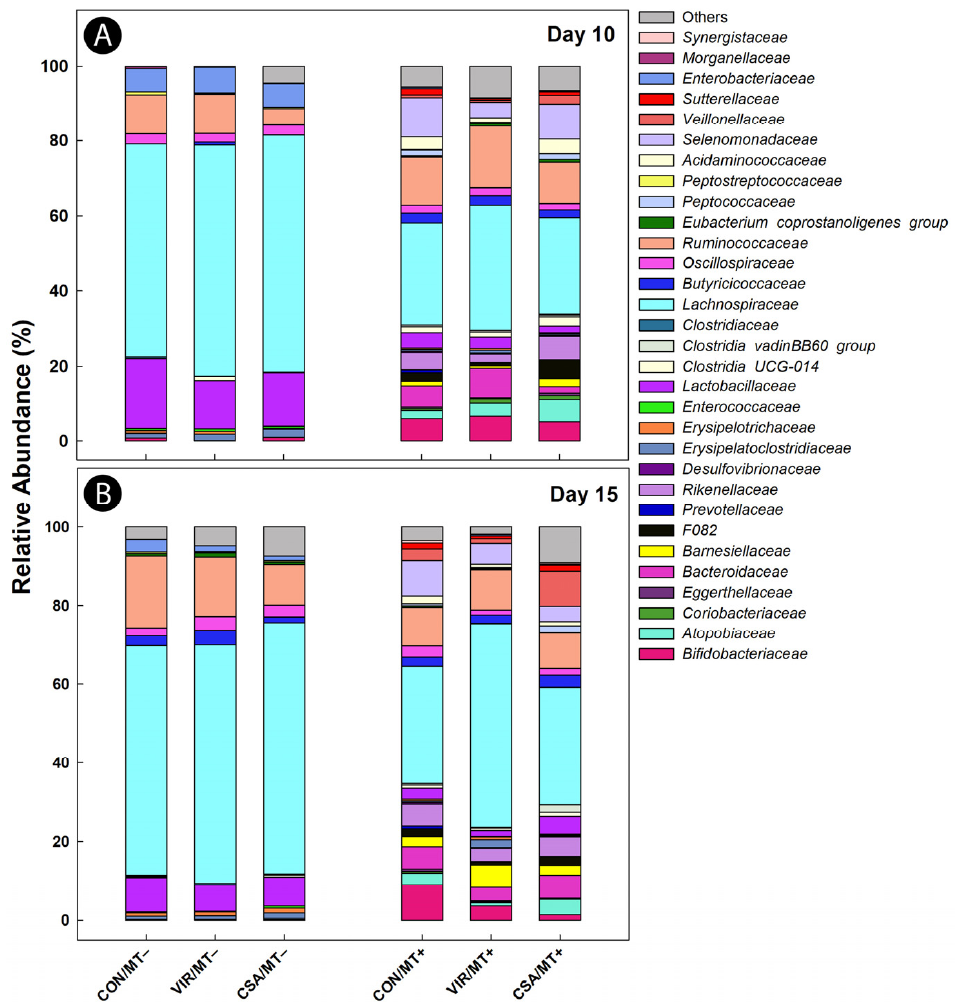
Figure 1. Relative abundance of bacterial communities in the cecal digesta of broiler chicks admin- istered an unamended starter diet (CON), a diet supplemented with virginiamycin (VIR), or a diet supplemented with the ceragenin, CSA-44 (CSA). Birds received a microbiota transplant (MT+) or buffer alone (MT − ) on day 1 post-hatch. ( A ) Day 10 post-hatch; ( B ) day 15 post-hatch.